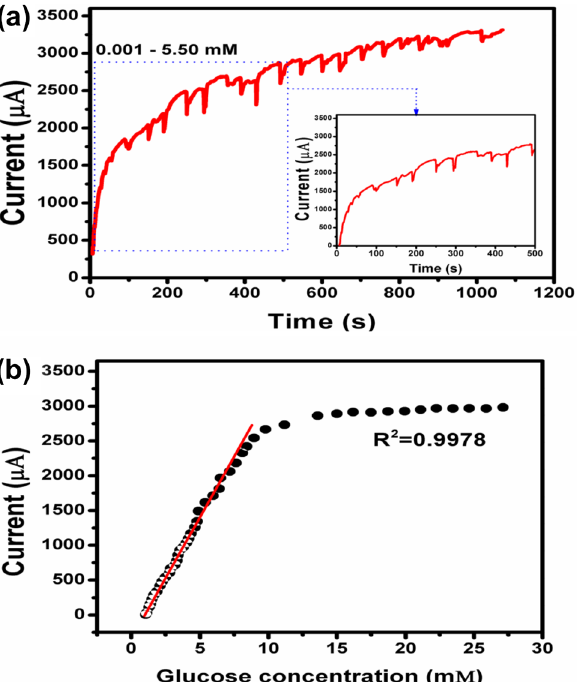
Figure 4. ( a ) Amperometric result of CuO/Ag/NiO–GCE at + 0.58 V in 0.1 M NaOH solution with various glucose concentrations from 0.001 to 5.50 mM and inset response curve shows the low concentration range of glucose (0.001–2.95 mM). ( b ) Plot illustrating the current response vs. glucose